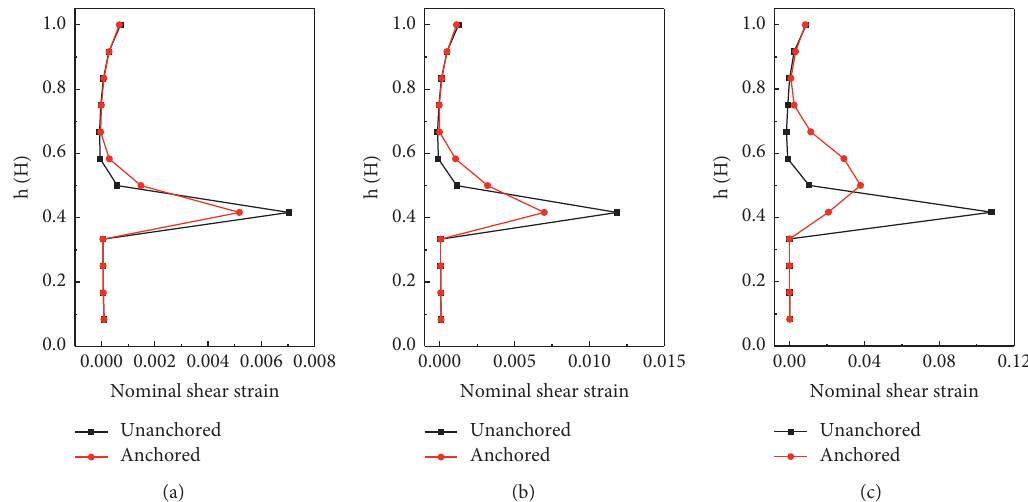
Figure 6: Nominal shear strain distribution along the elevation of the slope surface under different seismic waves: (a) the seismic wave is the Kobe earthquake time series; (b) the seismic wave is the El Centro earthquake time series; (c) the seismic wave is cosine